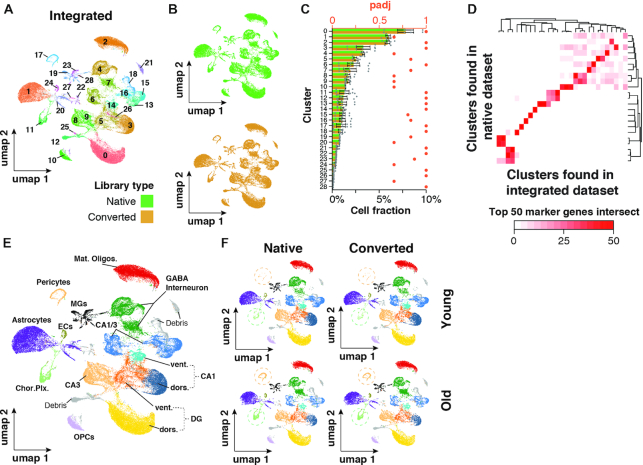
Integrated native and CooMPS-compatible snRNA-seq datasets show no separation by library type. (A, B) UMAP representation of cells and clustering results of n = 60,0720 cells integrated from both datasets. Cells are colored by (A) cluster or (B) library type. Cells were split by library type to improve visibility. (C) Relative abundance of each cluster normalized to total cells. Relative abundances are split by library type to gauge conversion-dependent composition of clusters. n = 4 per dataset. Means ± SEM. ***Padj < 0.001, **Padj < 0.01, *Padj < 0.05, two-sided Wilcoxon rank-sum test, adjusted for multiple testing. Adjusted P-values for paired, two-sided Wilcoxon test probing differential abundance per cluster are shown in red. (D) Heatmap depicting the number of common top 50 genes per cluster as detected in either integrated or native dataset. (E, F) UMAP representation of cell populations from integration dataset when (A) collapsed or (B) split by dataset and age. Circles highlight differential abundance of choroid plexus-derived cells and Pericytes. Abbreviations: DG dors., granule neurons of dorsal dentate gyrus; DG vent., granule neurons of ventral dentate gyrus; CA1 dors., pyramidal neurons of dorsal CA1; CA1 vent., pyramidal neurons of ventral CA1; CA3 dors., pyramidal neurons of dorsal CA3; CA1/CA3 Neur., pyramidal neurons that could not be clearly allocated to CA1 and CA3; GABA interneuron, gabaergic interneurons; Mat. oligos, mature oligodendrocytes; OPCs, oligodendrocyte precursors; MGs, microglia; Chor. Plx., choroid plexus cells; ECs, brain endothelial cells; a.u., arbitrary unit; obs./exp., observed over expected; Padj, adjusted P-value.